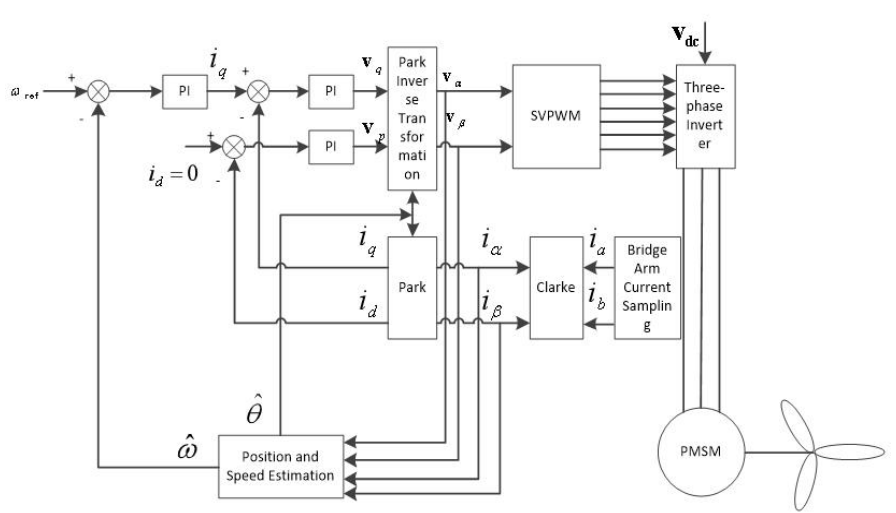
Figure 1. Spindle speed control composition